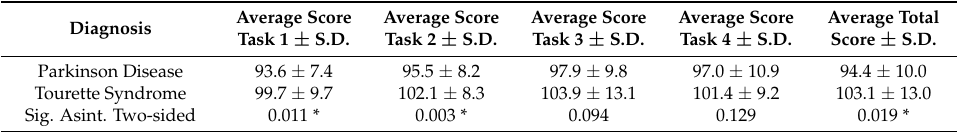
Table 6. Average scores of the sample in the four tasks and average total score.